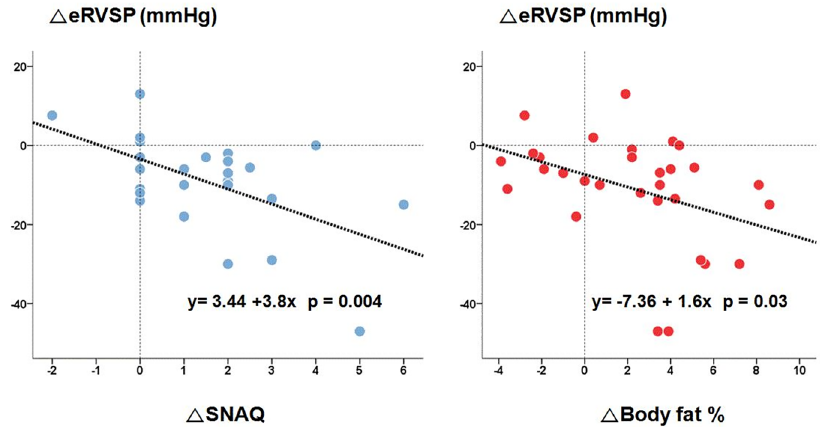
Fig 2. Relationship of Δ SNAQ and body fat percentage with Δ eRVSP in patients with mitral regurgitation. Pearson’s coefficient(r). SNAQ, short nutritional assessmentquestionnaire; eRVSP, estimated right ventricular systolic